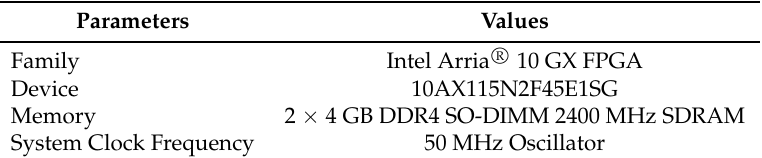
Table 4. Intel Arria R (cid:13) 10 GX FPGA Specifications.